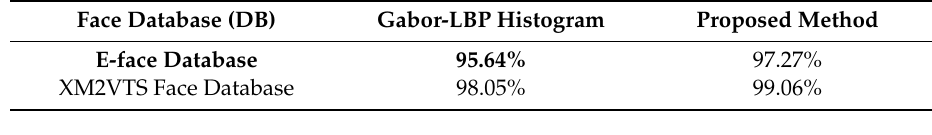
database containing sixteen different illuminations using the following criteria: TAR—true